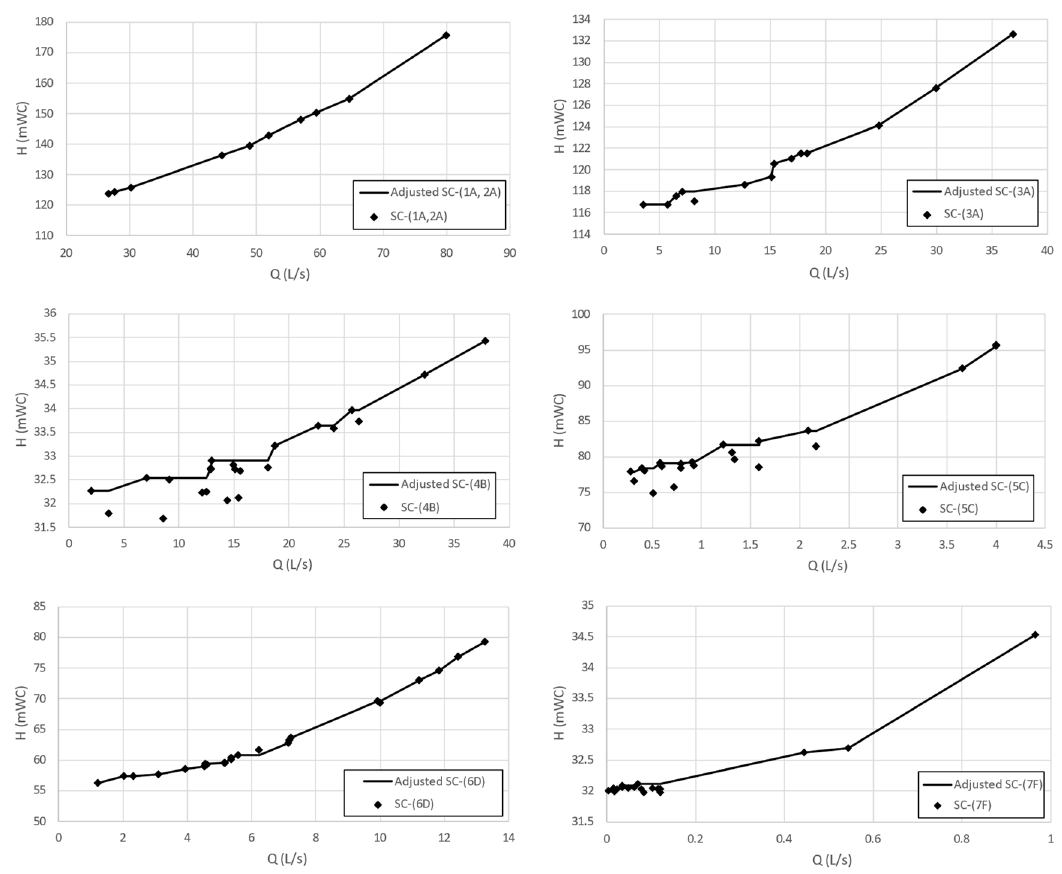
Figure 11. Readjusted setpoint curves for pumping stations on the Richmond network.